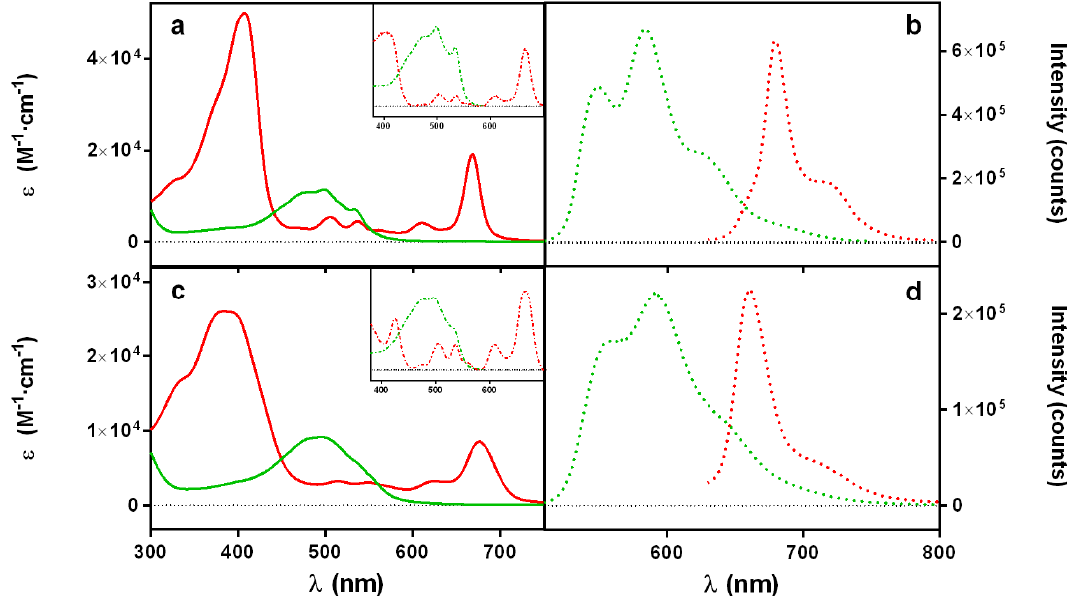
Figure 2. Absorption ( a , c ) and fluorescence ( b , d ) spectra of DOXO (green) and PhA (red) in EtOH ( a , b ) and water ( c , d ). DOXO was excited at 455 nm and PhA at 610 nm. Insets: ( a , c ) excitation spectra of the fluorescence at 705 nm for PhA and 610 nm for DOXO.